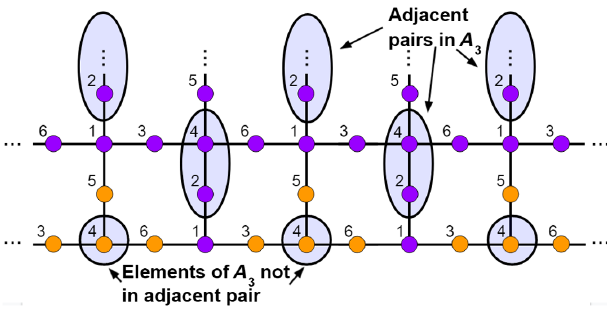
FIG. 16. For any given A , here we take without loss of i generality i ¼ 3 , some elements of A have a neighbor also in i A . Other sites in A have no such nearest neighbor. As described i i in Appendix G, all sites evolve in the near-Zeno approximation in one of two ways. Lone sites in A and nearest neighbors to lone i sites in A (as shown in orange) exhibit an evolution given by i case 1 of the near-Zeno term of Eq. (G3). However, the evolution for sites that are in an adjacent pair in A or neighboring an i adjacent pair in A (shown in purple) are governed by case i